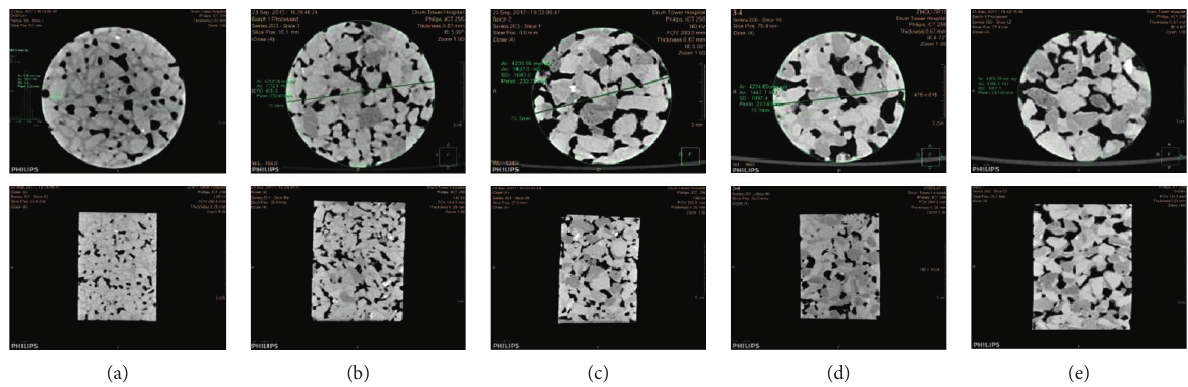
Figure 11: Cross section and longitudinal section of RAPC under CT scanning: (a) RAPC0; (b) RAPC25; (c) RAPC50; (d) RAPC75; (e) RAPC100.